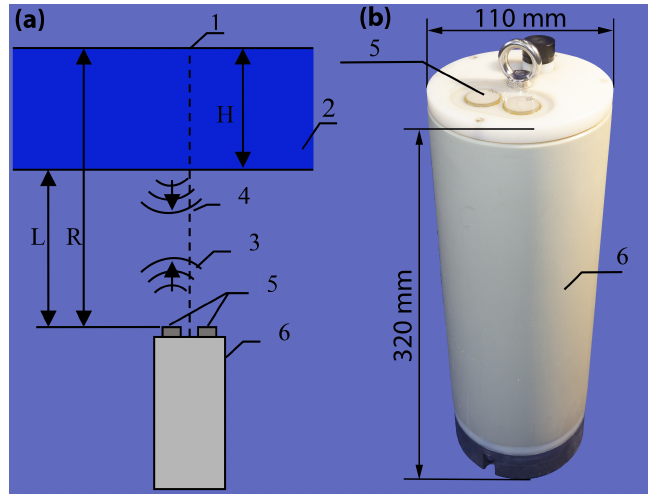
Figure 4. ( a ) Operating principle of the ice thickness meter: 1—suspension system, 2—ice, 3— emitted signal, 4—reflected signal, 5—hydroacoustic transducers, 6—device body; ( b ) photo of the device